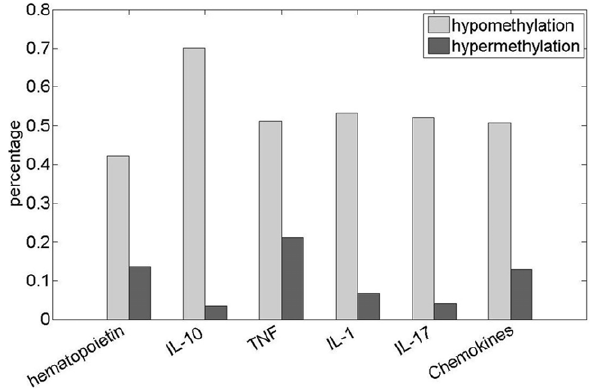
Figure 4. Hypomethylation and hypermethylation of six cytokine gene families. This figure illustrates the percentage of hypomethylated genes and hypermethylated genes in six cytokine gene families. The x-axis denotes the gene family, and the y-axis denotes the percentages of hypomethylated and hypermethylated genes in each of these gene families. The light and dark grey areas represent the hypomethylated and hypermethylated genes, respec-